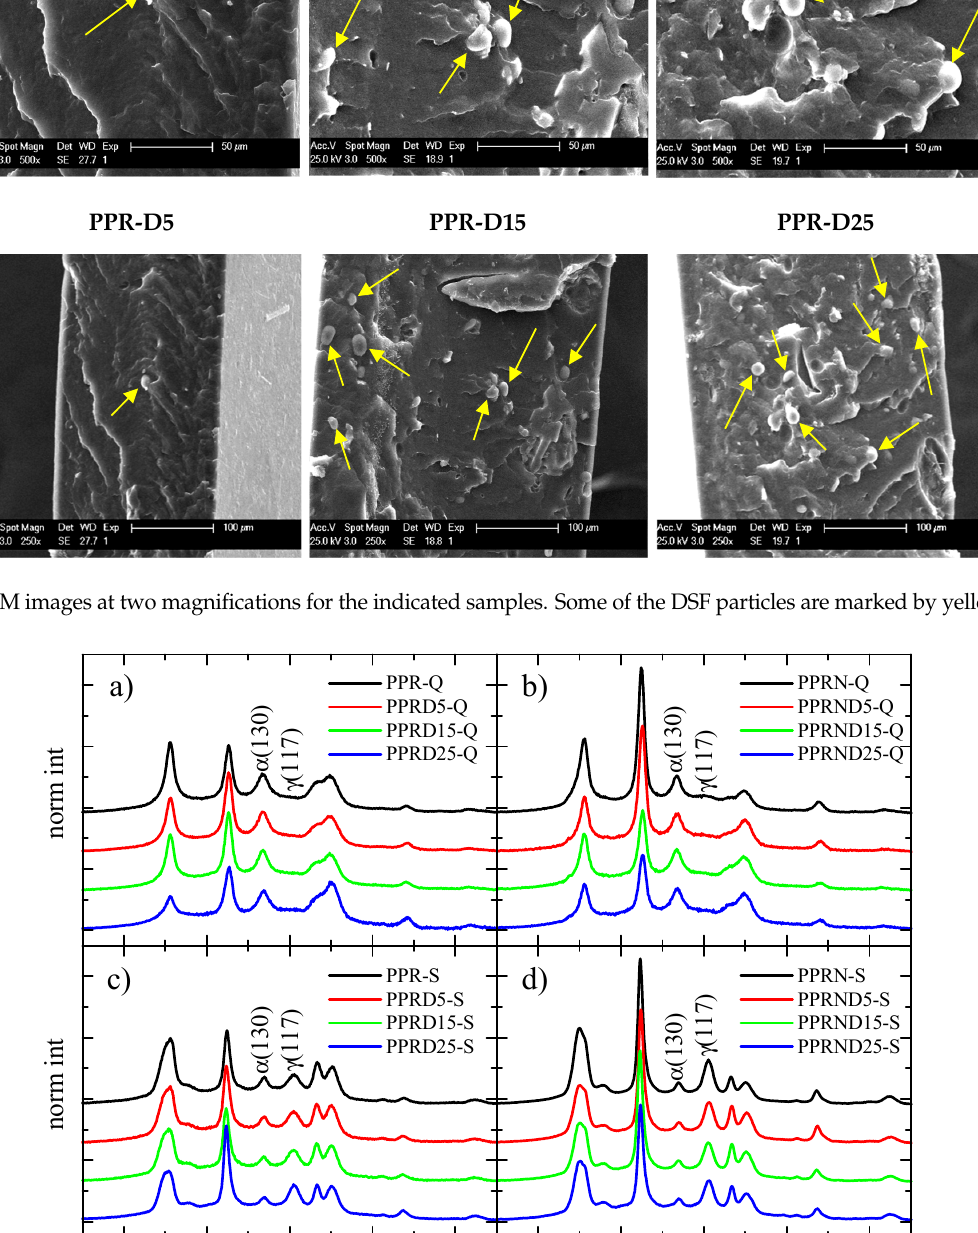
Polymers 2021 , 13 , 2957